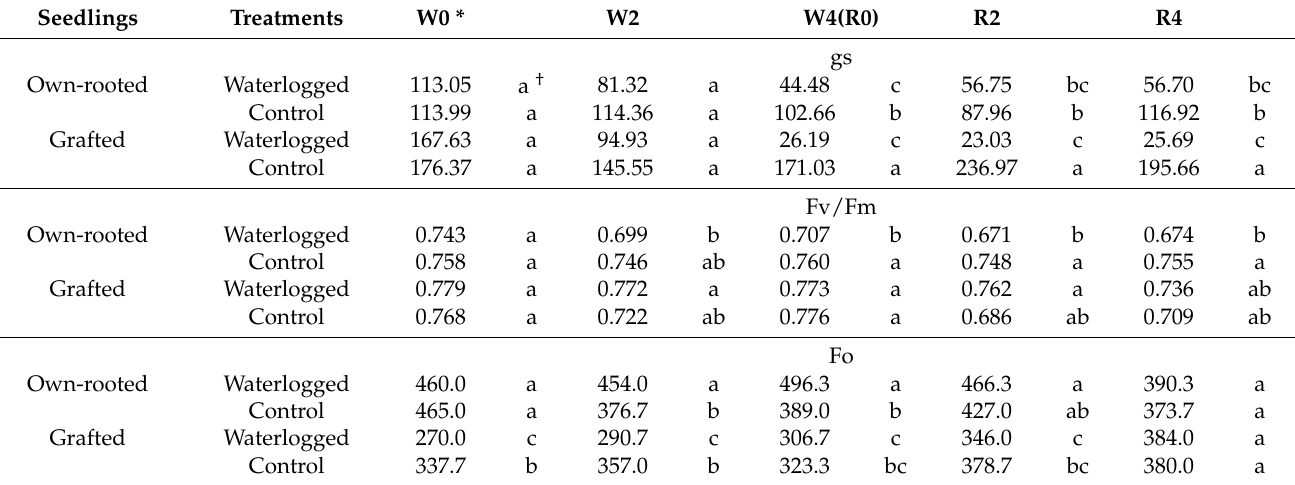
Table 2. Stomatal conductance (gs), Fv/Fm, and Fo of avocado cultivar ‘Hung-Hsin-Yuan’ during 4-day waterlogging and 4-day post-waterlogging